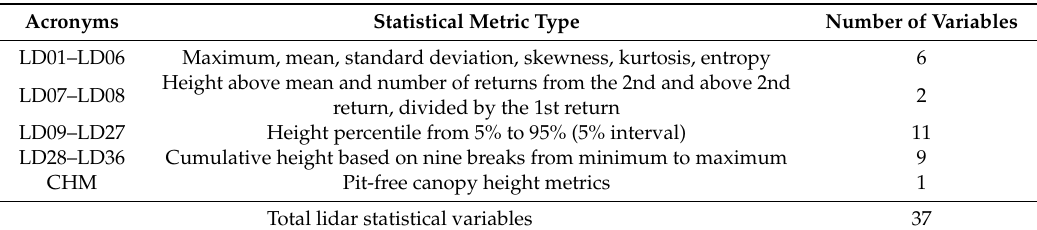
Table 3. Lidar metrics variable acronyms.